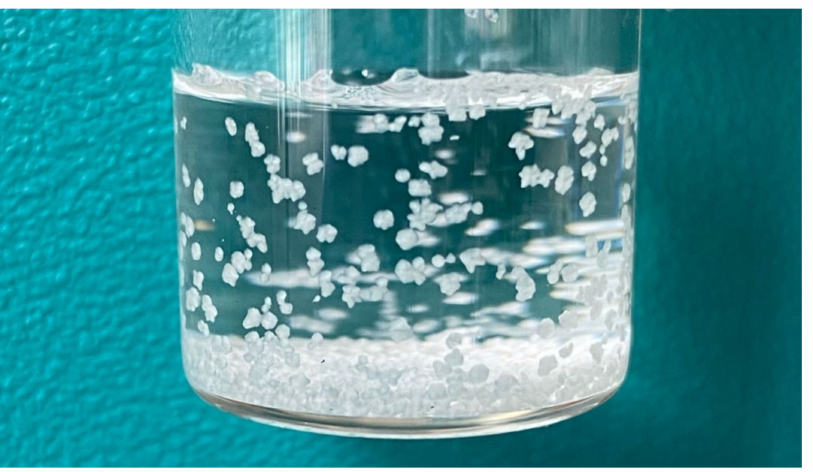
Figure 4. Flecainide crystals obtained from a solution containing sucrose, citrate buffer, and methyl- paraben